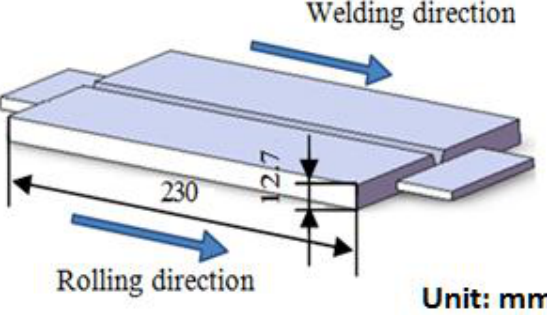
Figure 1. Welding direction for dissimilar material welding between Alloy 617 and 12Cr steel.